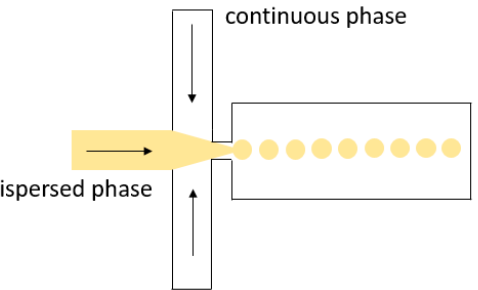
Figure 4. Droplet generation in a flow-focusing device. Small spherical droplets are formed in the channel resulting in droplet flow.